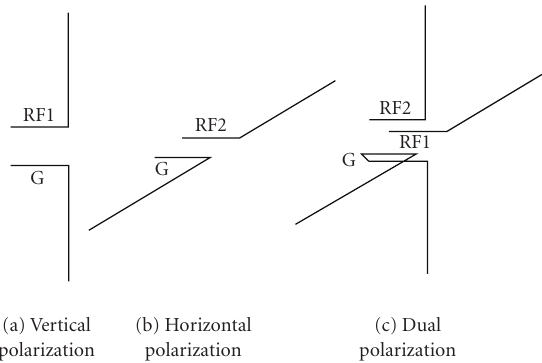
Figure 5: Polarization definition in dual antenna design.